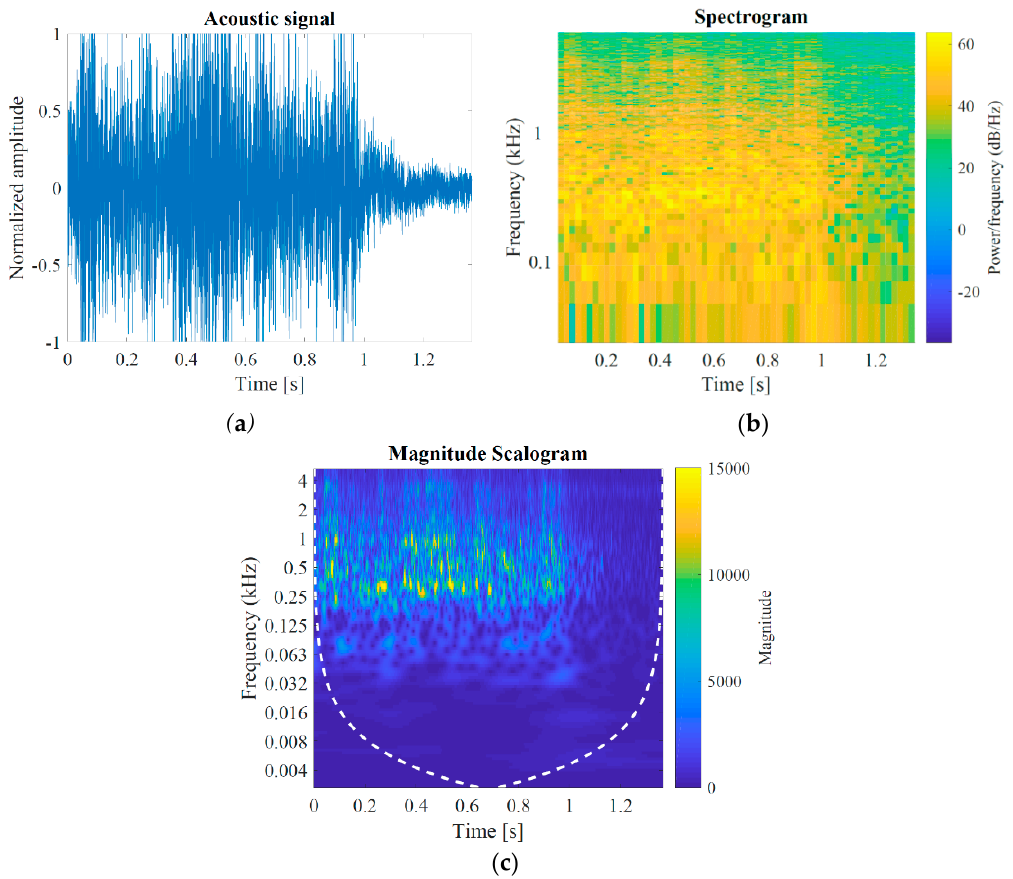
Figure 4. ( a ) Raw acoustic signal at blowout of Case 1. ( b ) Spectrogram of the signal at 2 9 window size and 50% overlapping. ( c ) Magnitude scalogram of the signal by using a Morse wavelet.